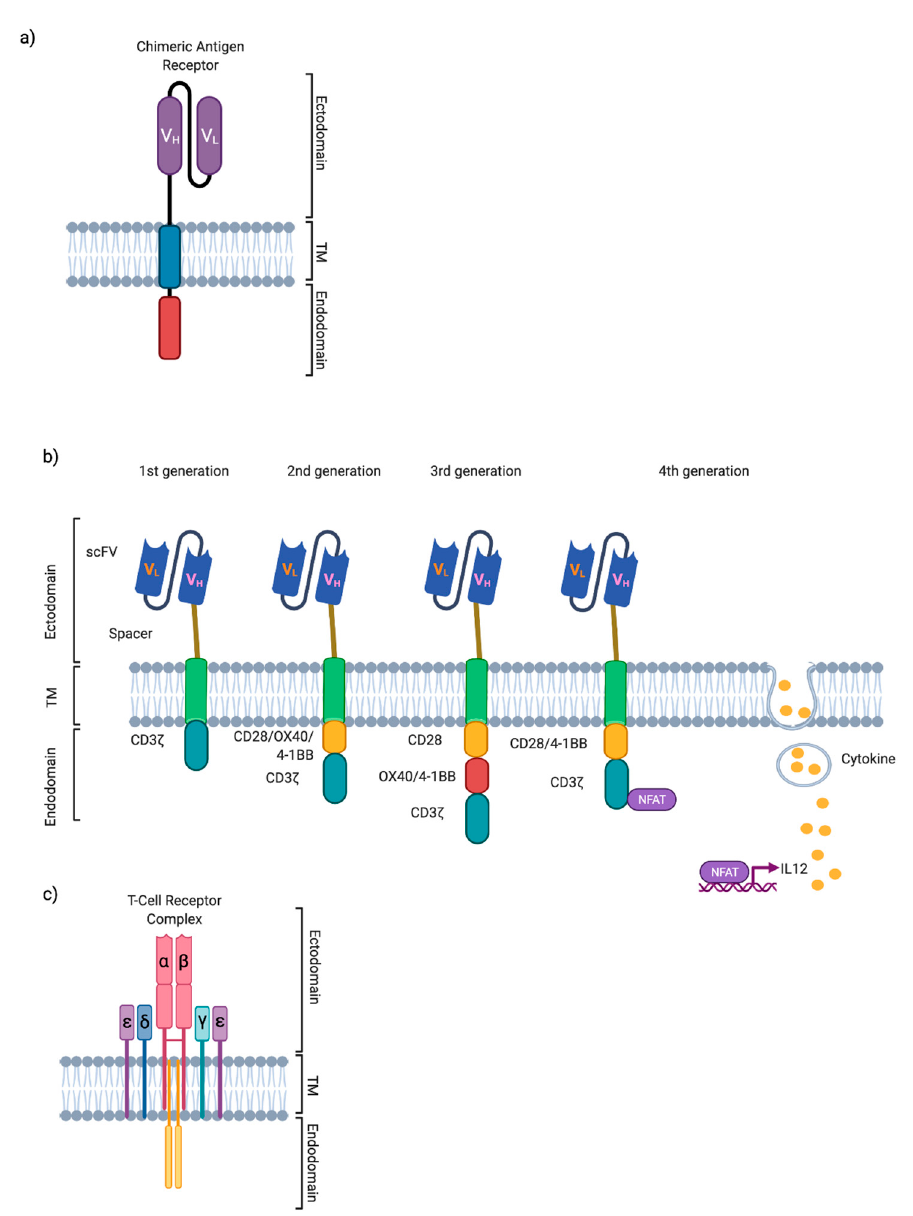
Figure 2. Structure of T-cell receptors (TCR) and Chimeric antigen receptors (CAR-T). ( a ) CAR-T cells recognise tumour antigens in an MHC-unrestricted manner. Target binding induces T cell activation, proliferation and cytotoxicity. ( b ) CAR-T design has evolved over time. 1st generation CARs comprise an extracellular scFv recognising a specific antigen connected to a transmembrane domain via a hinge with a CD3 ζ endodomain. 2nd generation CARs include an additional costimulatory moeity such as CD28, whereas 3rd generation CARs have two co-stimulatory domains linked to the CD3 ζ chain, e.g., 41BB and CD28, with the aim of improving CAR-T functionality and persistence. 4th generation CARs, ‘armoured CARs’, incorporate modules for cytokine production, e.g., IL-12, with the aim of improving CAR-T proliferation and persistence whilst concurrently stimulating endogenous immune compartments within the tumour microenvironment. ( c ) The T cell receptor (TCR) complex comprises engineered α and β chains in association with CD3 chains. Engineered TCRs interact with major histocompatibility complex (MHC)-antigen peptide complexes on cancer cells, to induce T cell activation and to promote tumour